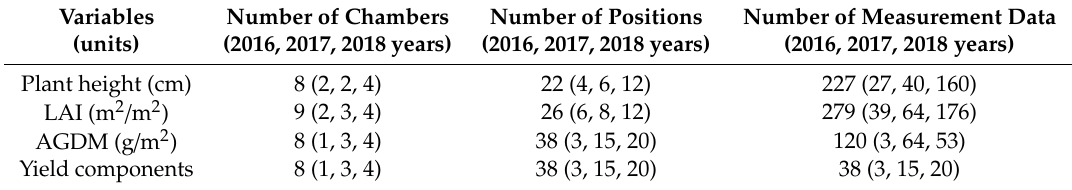
Table 1. Information of ground measurements on growth parameters for three